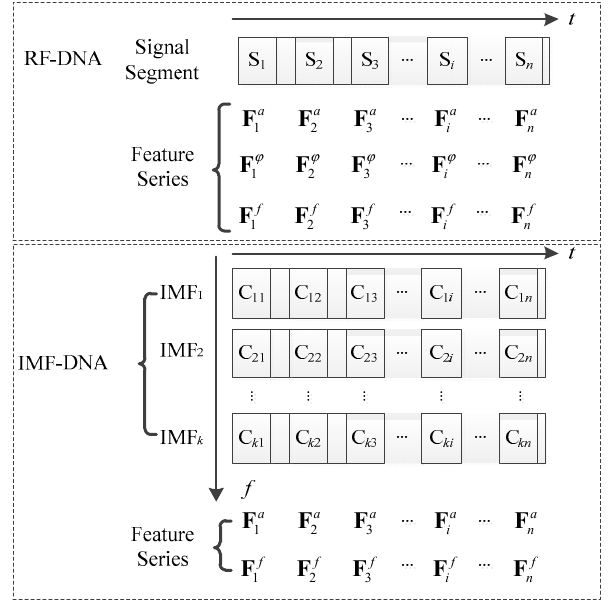
Figure 4. The comparison of the process flows of the proposed specific emitter identification (SEI) using the intrinsic mode function distinct native attribute (IMF-DNA) algorithm and the radio frequency DNA (RF-DNA) algorithm.